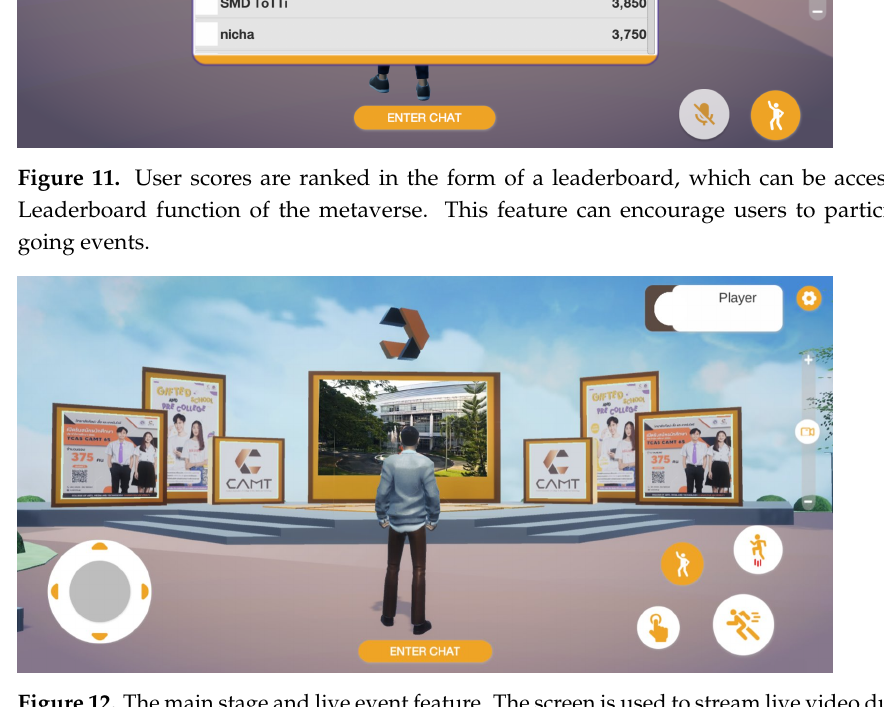
Figure 12. The main stage and live event feature. The screen is used to stream live video during events. The Thai words on the left and right boards over the orange colour bar is “Open for